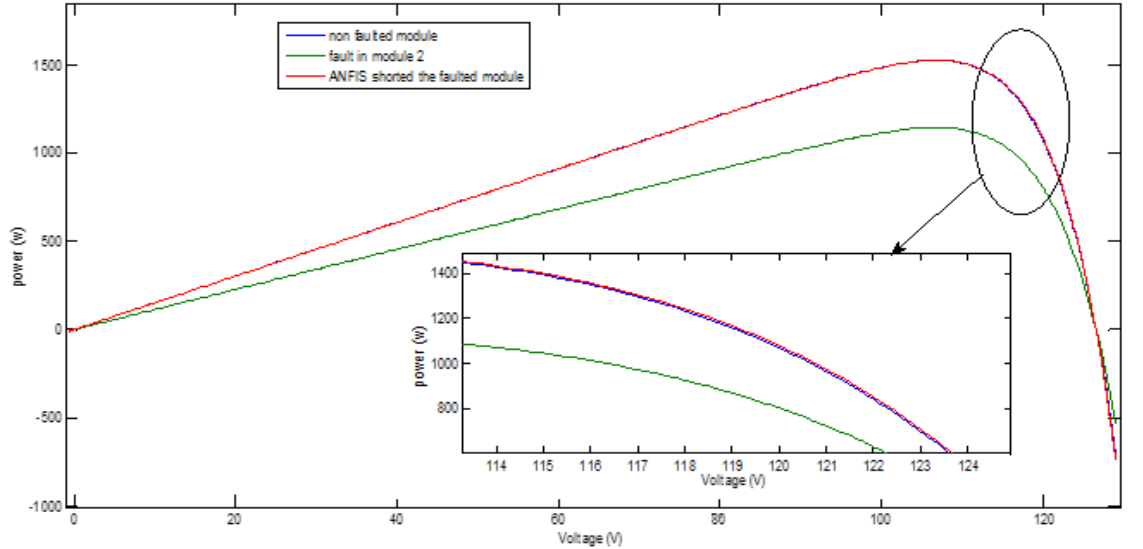
Figure 10. Effect of open-circuit fault occurred in a certain group on the power output of PV string.